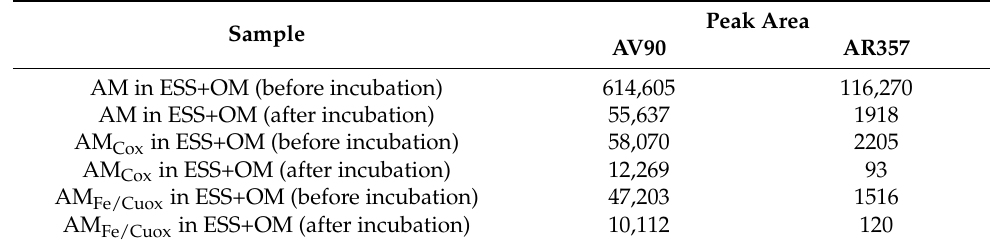
Table 6. Variation of the detected chromatographic peak areas for AV90 and AR357 substrate components for different removal treatments.